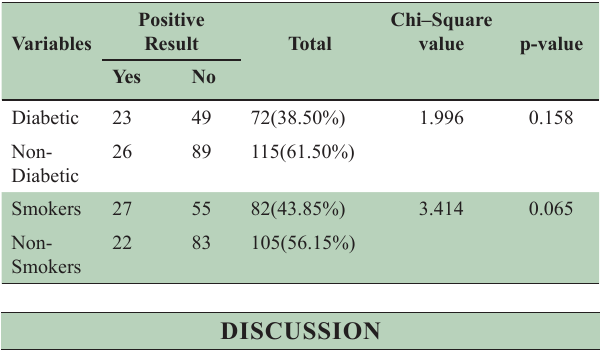
Chi-square value = 0.001 Table-VI: Table of association among the diabetic, smokers, HIV patients and Gene